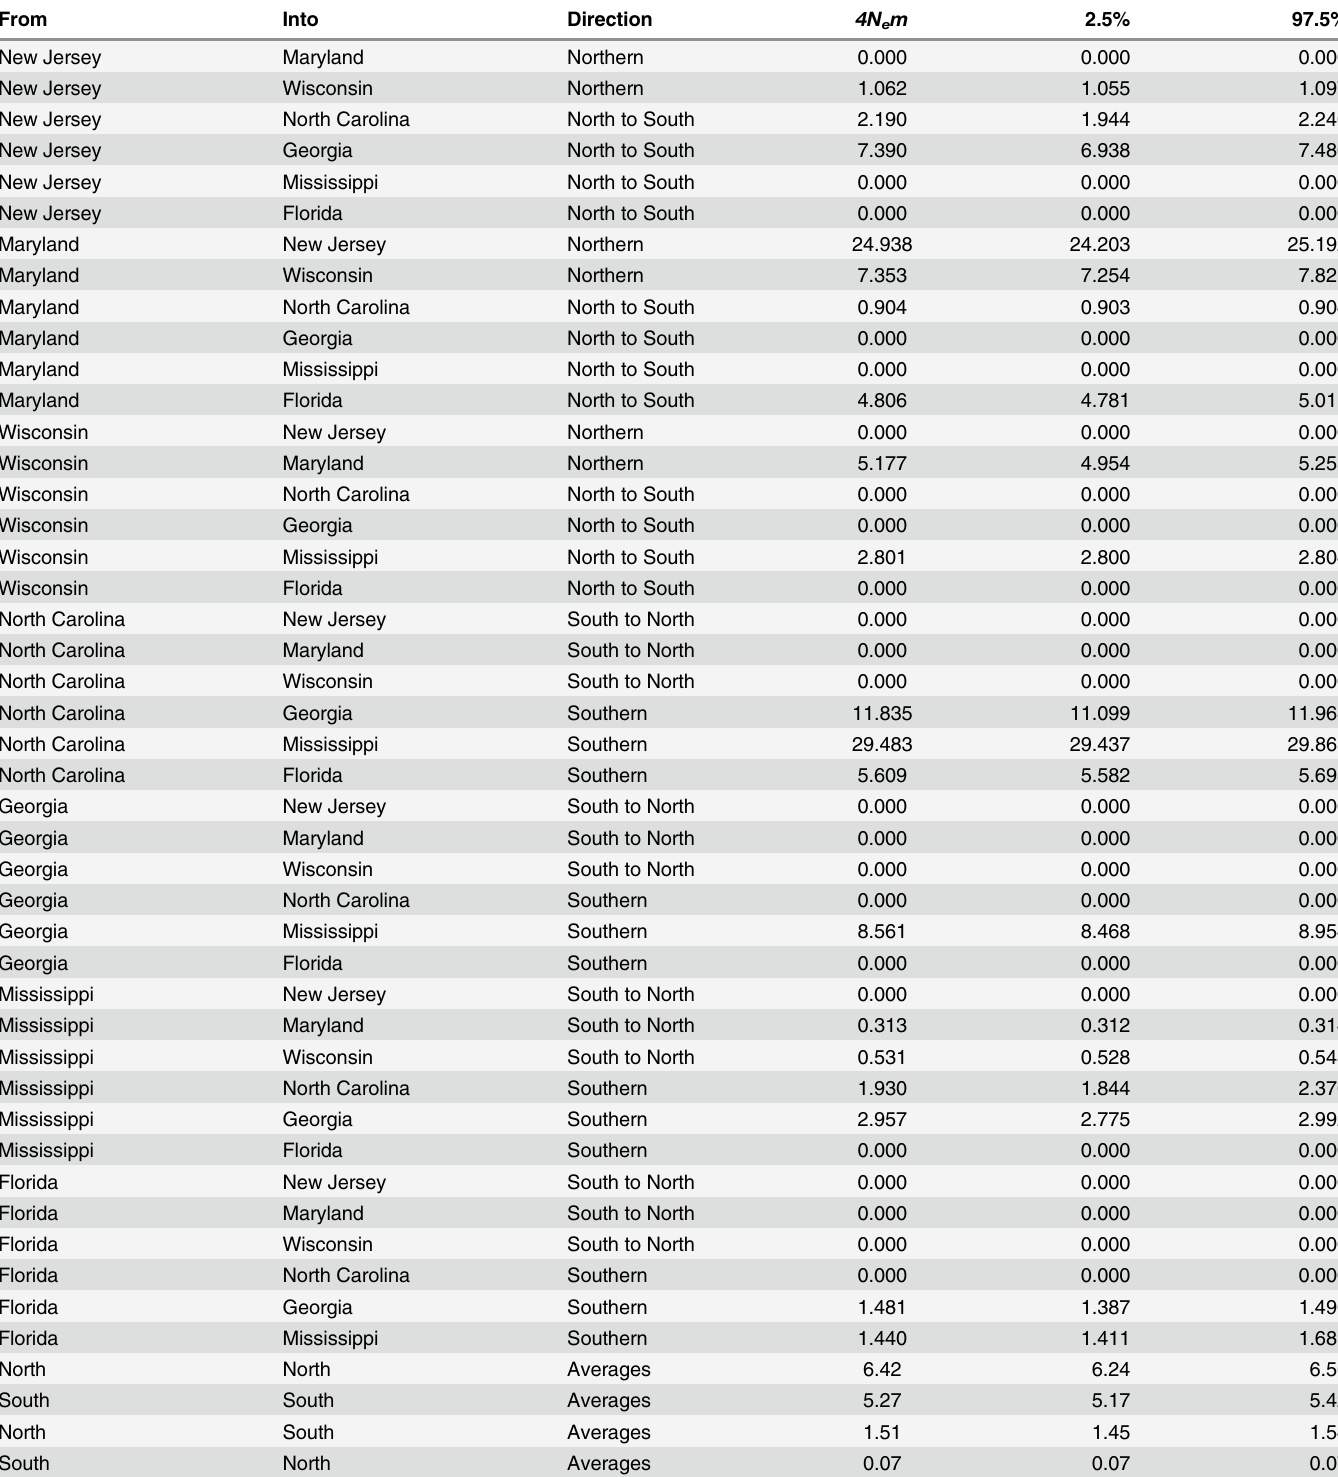
Table 5. Pairwise 4N e m and the lower 2.5% and upper 95% Highest Density Intervals (HDI) among all pairs of collections (42 pairs). Values at the base of the table are average 4N e m and their lower 2.5% and upper 95% HDI among northern collections (6 values), among southern collections (12 values), from north to south (12 values) and south to north (12